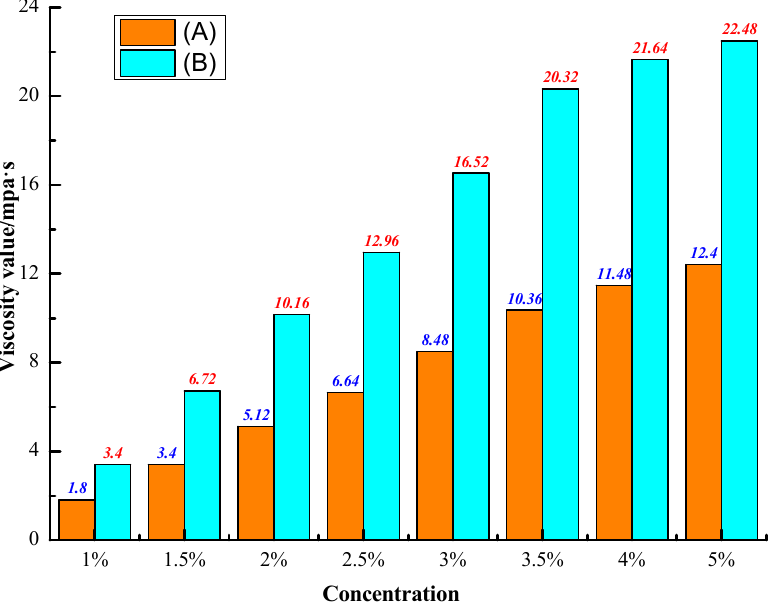
Figure 4. Viscosity histogram.